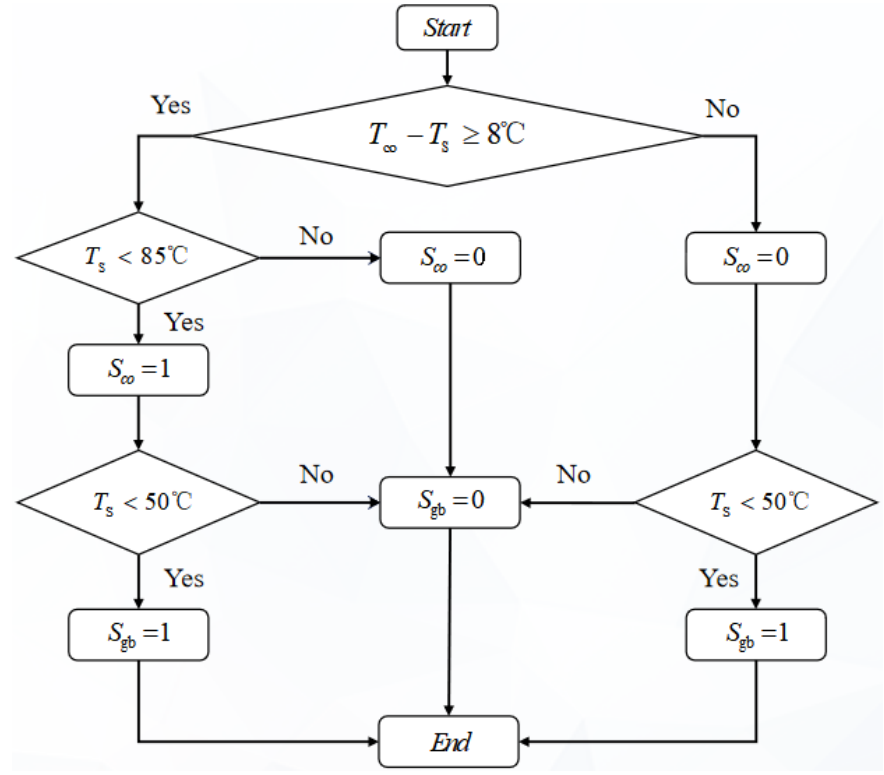
Figure 3. System control strategy diagram.